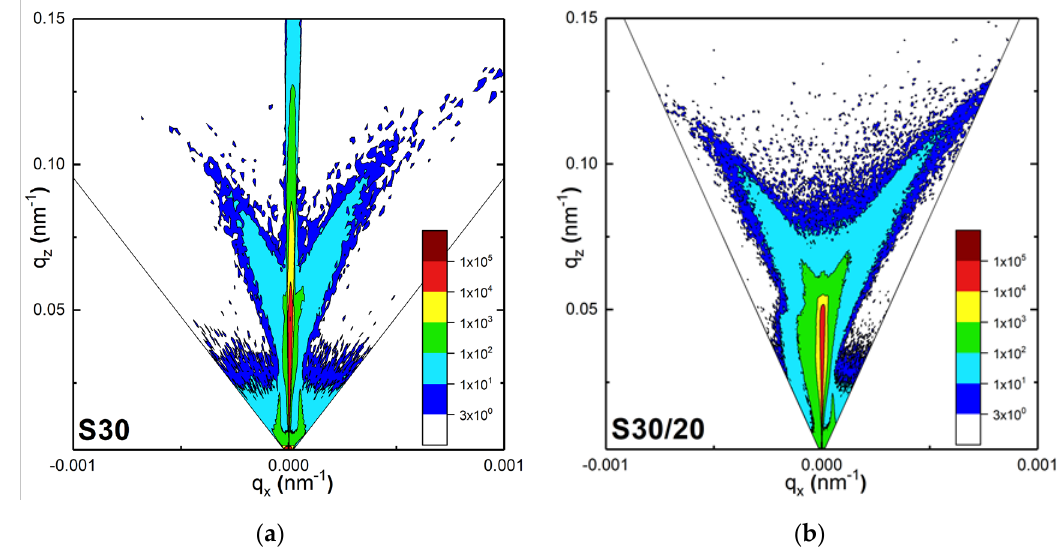
Figure 5. The experimental reciprocal space maps for ( a ) sample S30 and ( b ) S30/20 .